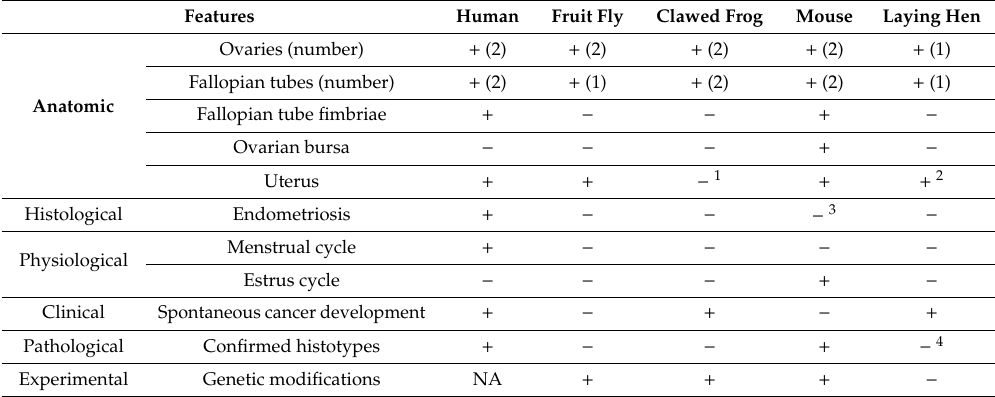
Table 1. Similarities and di ff erences between animal models and human ovarian cancer (partially based on the work of